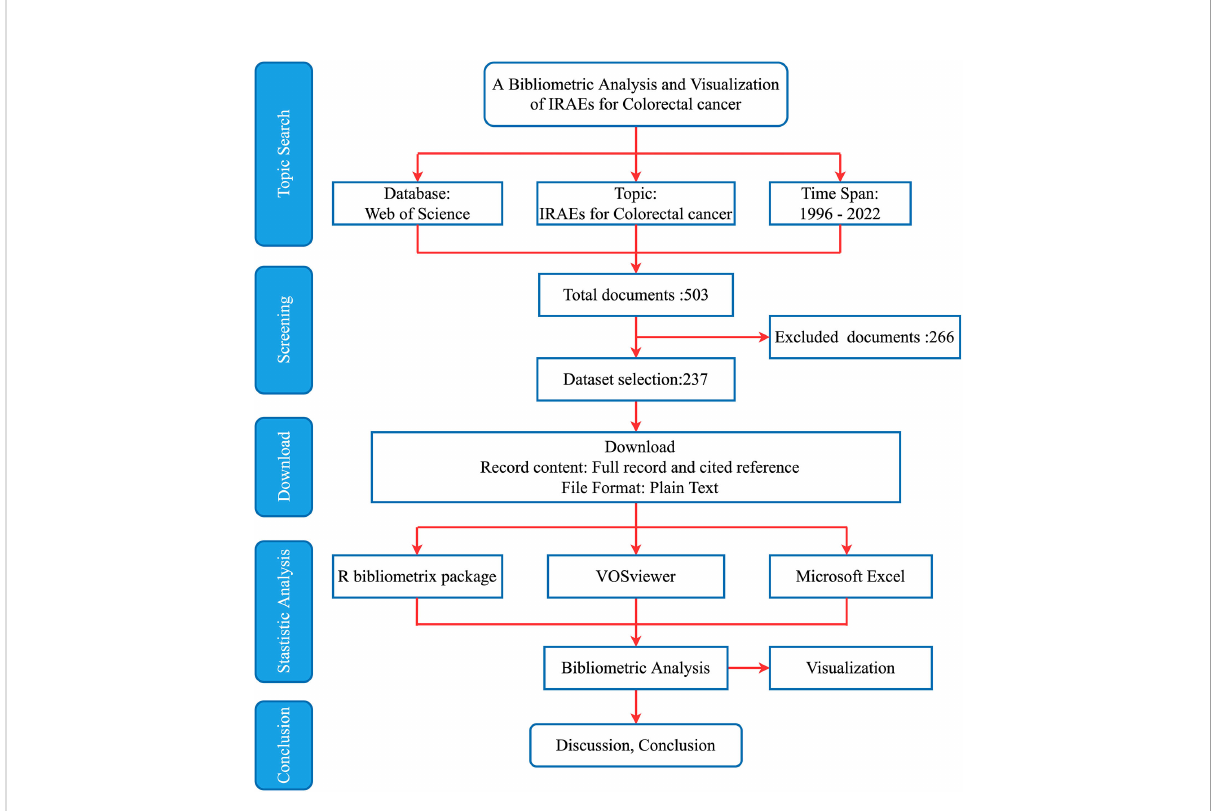
FIGURE 1 Flowchart of the bibliometric